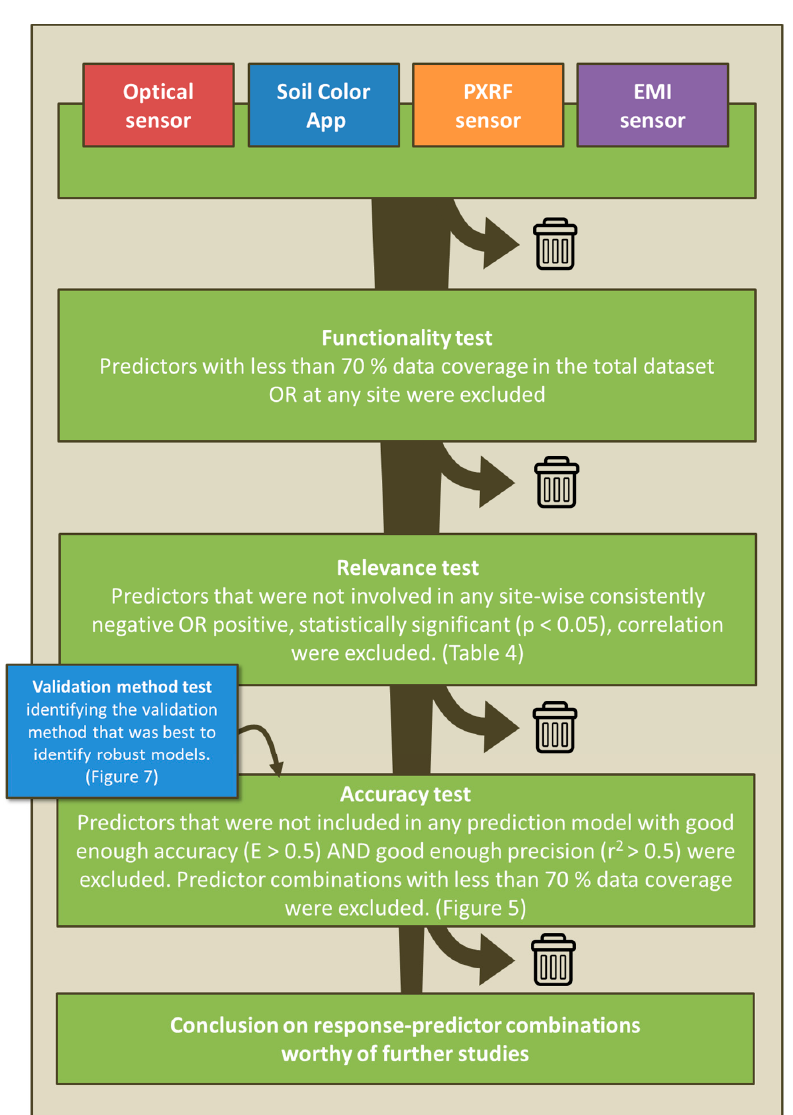
Figure 4. Schematic overview of the screening procedure carried out to select functional, robust, and accurate sensor-based prediction models. PXRF = portable X-ray fluorescence, EMI = electromagnetic induction, E = modelling efficiency, r 2 = coefficient of determination.